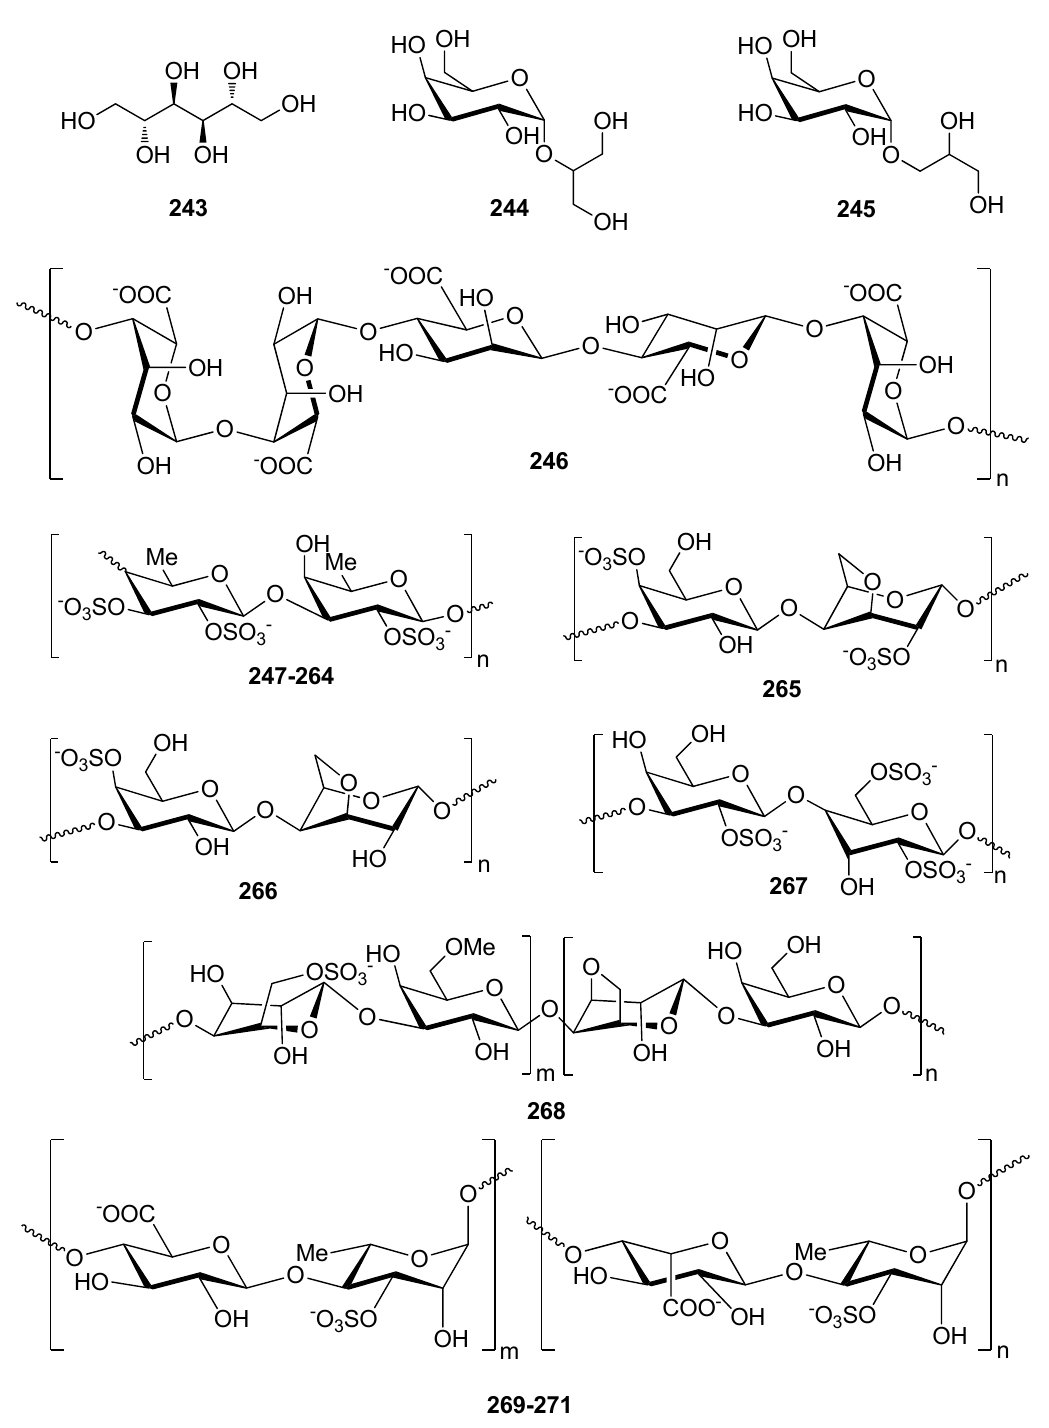
Figure 22. Chemical structures of compounds 243 – 271 . Additionally, Rodriguez-Jasso et al. (2014) isolated fucose-containing sulfated polysac- charides from Fucus vesiculosus using either microwave-assisted extraction ( 258 ) or autohy- drolysis ( 259 ) and their antioxidant activity was determined [217]. Both samples presented similar sulfate contents (~21%), as well as comparable antioxidant potential as evaluated by DPPH and ABTS + scavenging, and lipid oxidation inhibition methods. Differences in the antioxidant potential could be observed only when using a differential pulse